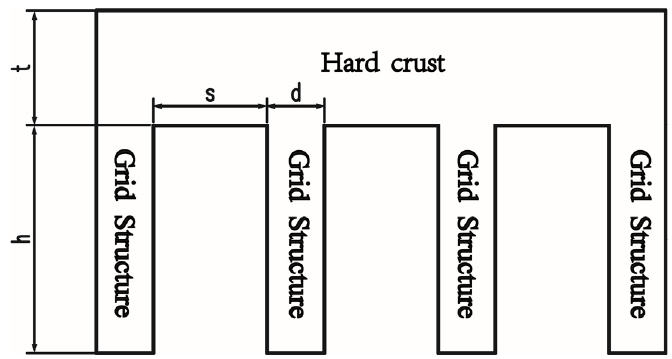
Figure 4. Schematic diagram of hard crust and grid structure. Table 1. Test scheme.